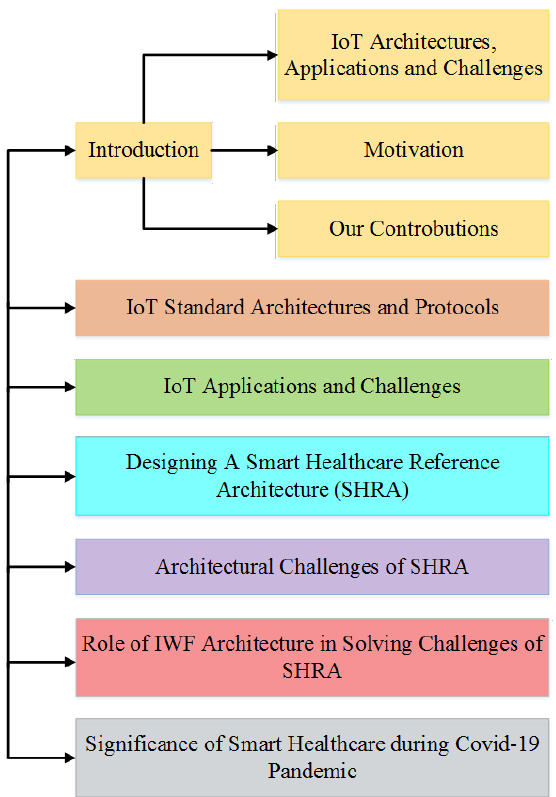
Figure 3. Road-map of the